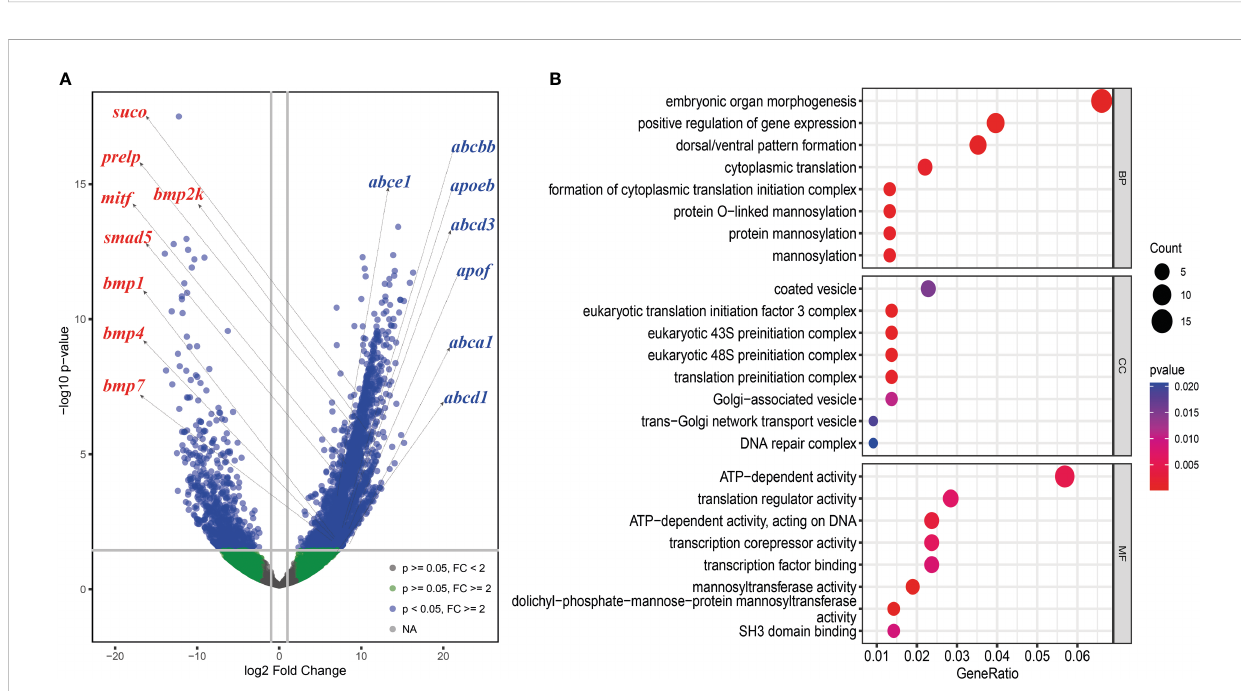
FIGURE 5 Differently expressed genes (DEGs) analysis between the skin of box fi sh and fugu. (A) Volcano map of DEGs showing the threshold line of the screening criteria. Several up-regulated genes related to bone plates (left with red color) and ostracitoxin secretion (right with blue color) are shown on the map. (B) GO enrichment analysis of up-regulated